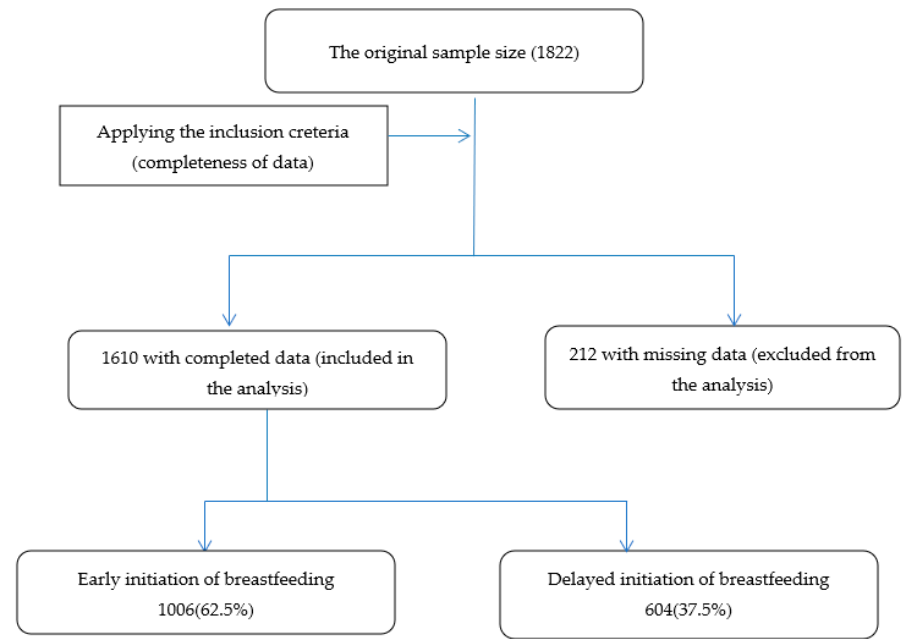
Figure 1. Shows the study participants flow chart including the main findings.